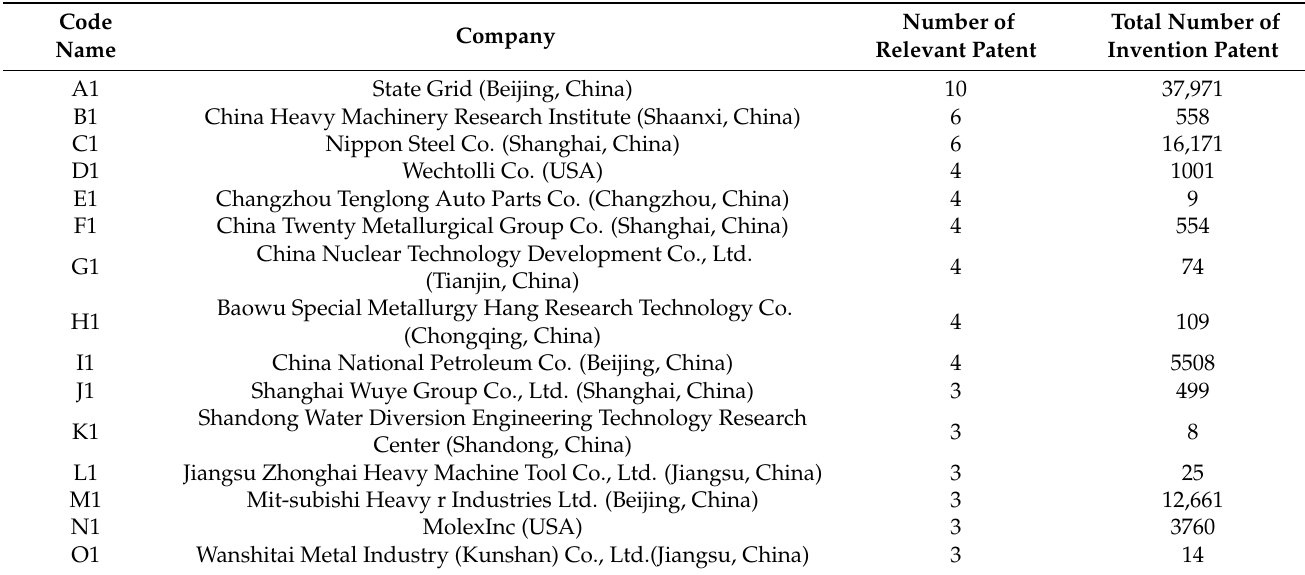
Table A3. Patents of the 15 companies (rotation).